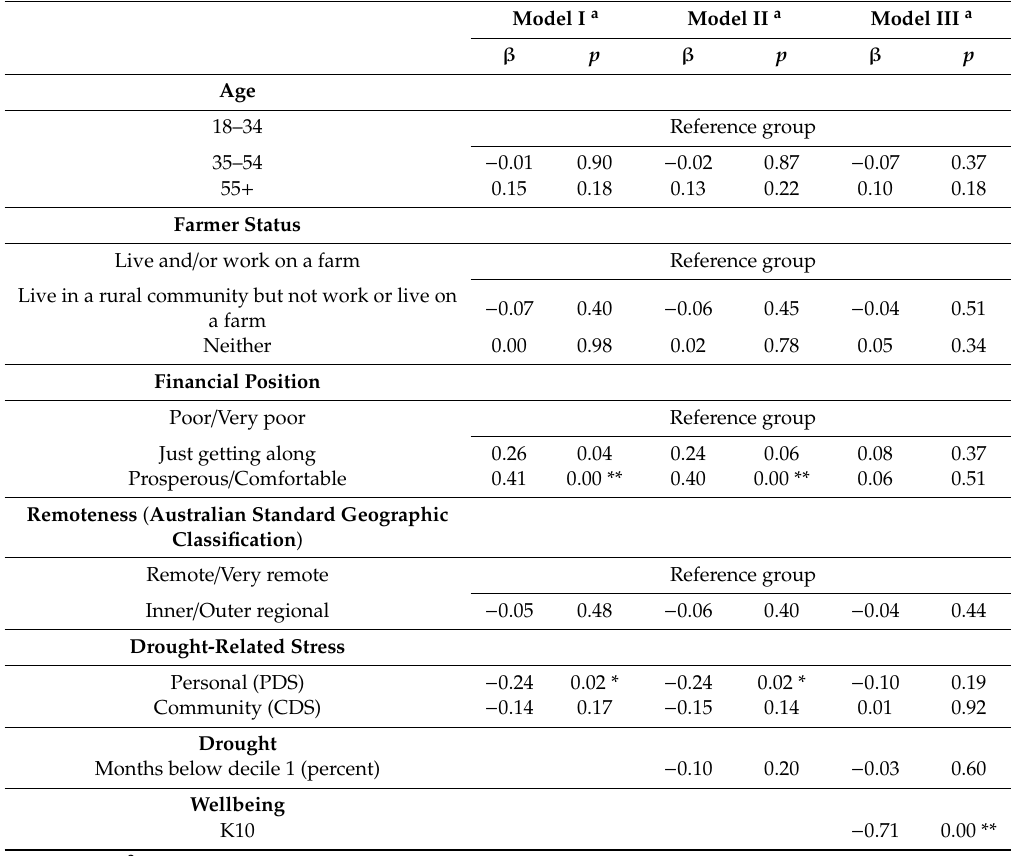
Table 7. Linear regression showing the relationships between SOC13 and the influencing factors of sociodemographics, drought-related stress, drought and